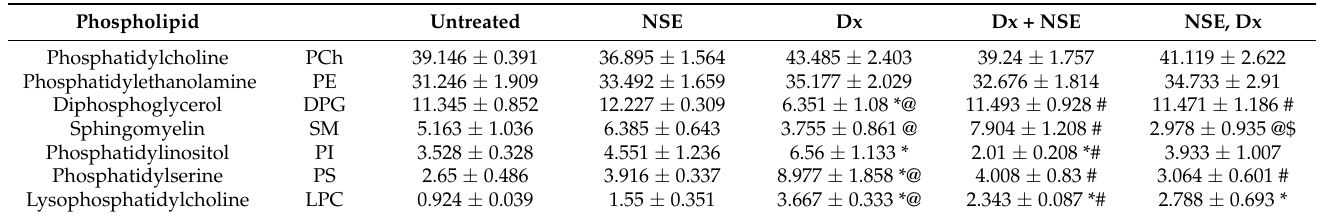
Table 3. Phospholipid profile in heart of mice treated with doxorubicin (7.5 mg/kg, i.p.) and NSE (350 mg/kg, per